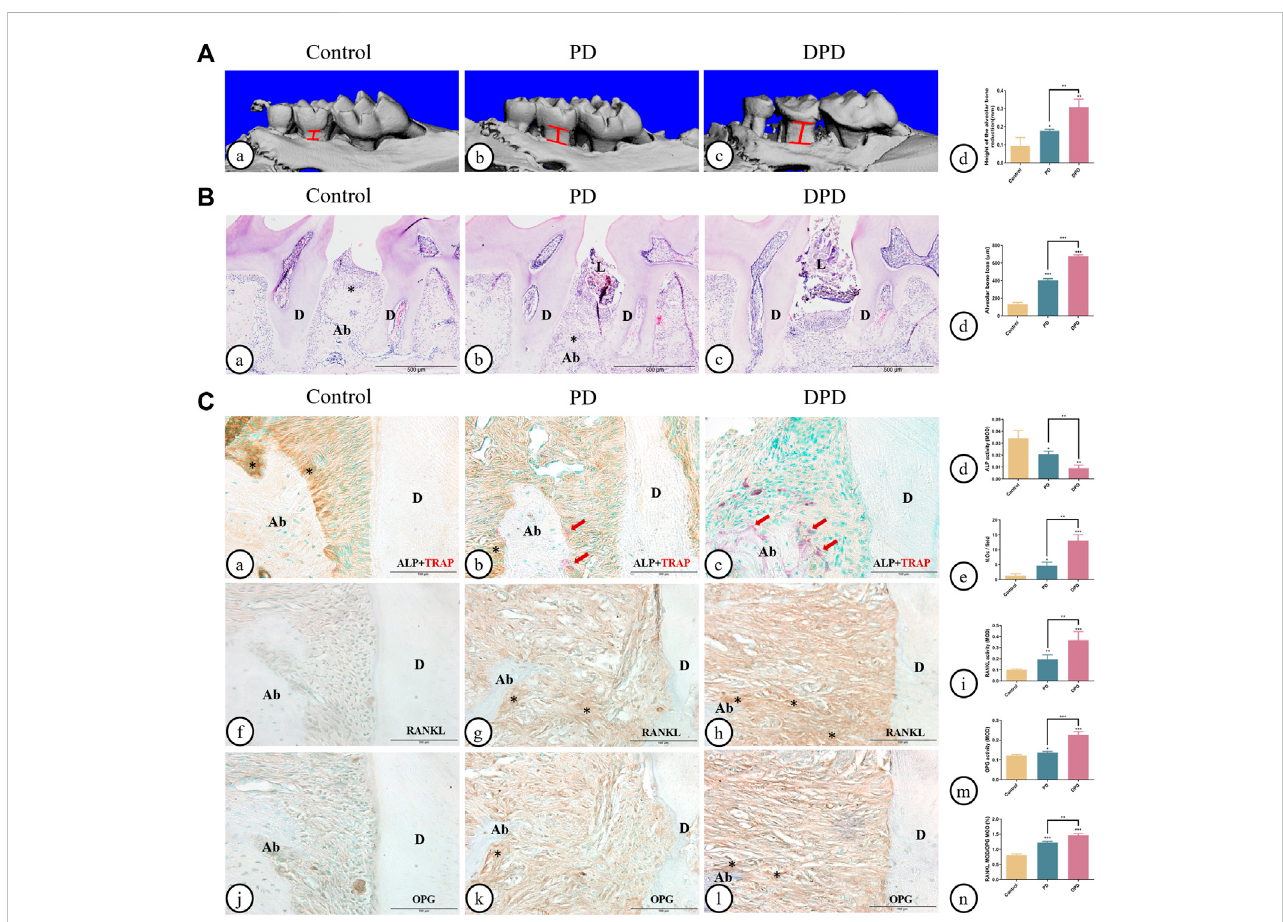
FIGURE 1 Micro-CT analysisand histological alterations in themaxillary alveolar bone. (A) 3D images ofmicro-CT inthe (A) control, (B) PD and (C) DPD groups. (d) Statistical analysis of alveolar bone loss. (B) Low magni fi cation of histological images of the alveolar bone in the (A) control, (B) PD and (C) DPD groups. (d) Statistical analysis of alveolar bone loss. “ * ” , the alveolar ridge crest. (C) Double staining for ALP (brown) and TRAP (red) in the alveolar bone of the (A) control, (B) PD and (C) DPD groups. (d) Statistical analyses of ALP positive. (e) TRAP positive osteoclast count. Immunostaining of RANKL in the (f) control, (g) PD and(h)DPDgroups.(i)Statisticalanalysis oftheactivityofRANKL.ImmunostainingofOPGinthe(j)control,(k)PDand(l)DPDgroups.(m)Statisticalanalysisof theactivityofOPG.(n)TheratioofRANKL/OPG.Positivestaininghasbeenmarkedwitharrowsor “ * ” inthe fi gures.Datawereshownasmean±SD(* p < 0.05. ** p < 0.01. *** p < 0.001 https://www.frontiersin.org/register. Ab, alveolar bone; D, dentin; L,